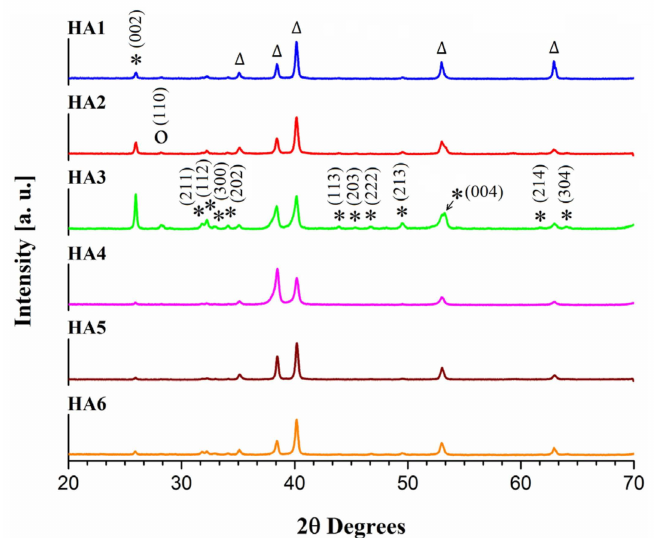
Figure 1. XRD patterns obtained for the HA1-HA6 samples, electrodeposited at 80 ◦ C. The ∆ symbol indicates the diffraction peaks corresponding to the Ti support. The O symbol indicates the diffraction peak possibly corresponding to octacalcium phosphate (OCP). The peaks that belong to HA are marked with